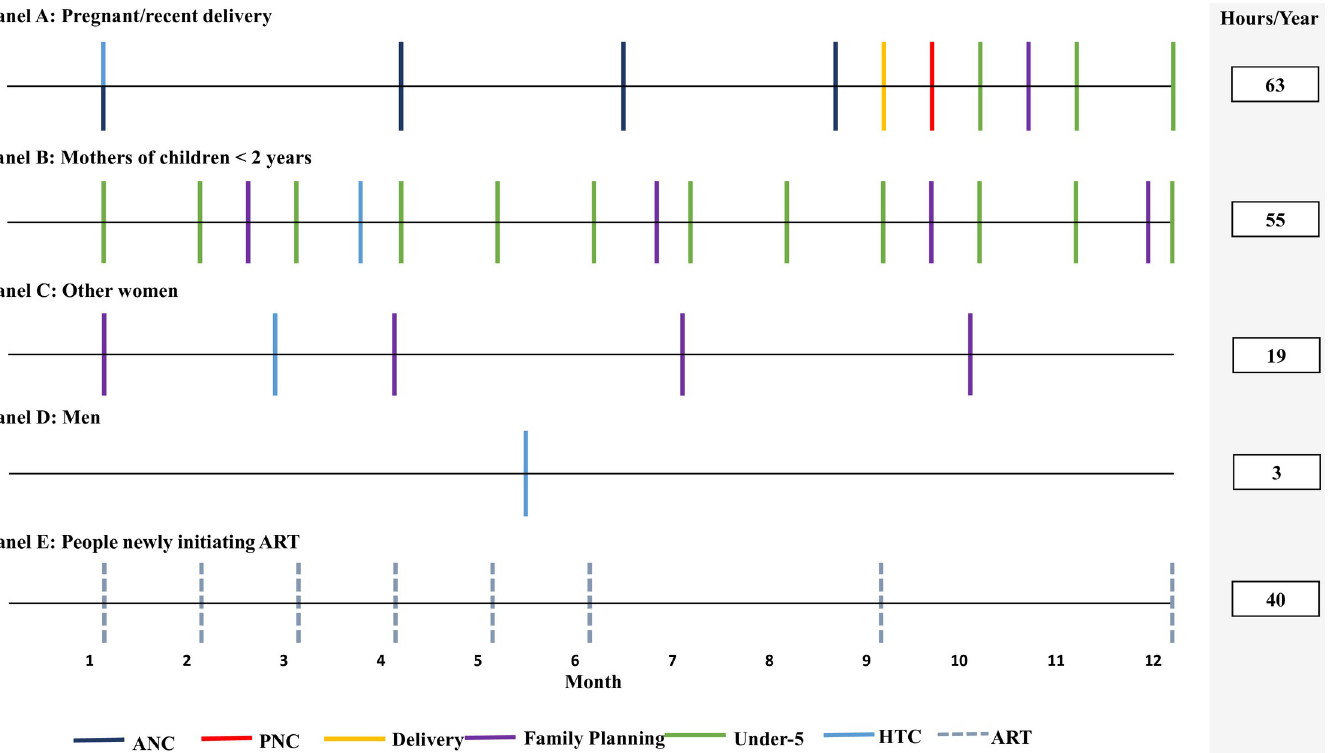
Fig 3. Annual recommended frequency of services and estimated time required by subpopulation. Visit frequency estimated based on national guidelines. Annual time required to meet guidelines is estimated from TLT calculations of median time required per service type (Table 1).